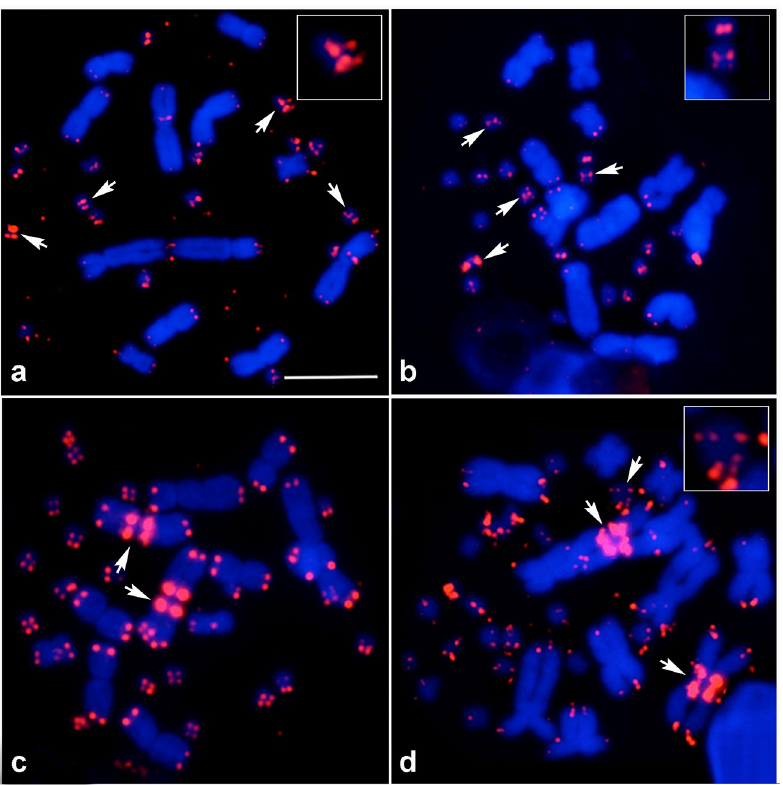
Fig 1. Chromosomal locations of (CCCTAA)n sequences in Pogona barbata and Diporiphora nobbi . Hybridisation pattern of Cy3-labelled CCCTAA repeats (red) in male P . barbata (a), female P . barbata (b), male D . nobbi (c) and female D . nobbi (d). Arrows indicate signals of interstitial telomeric sites (ITSs). The square box indicates the enlarged chromosome containing ITSs. Scale bar represents 10 μ m.